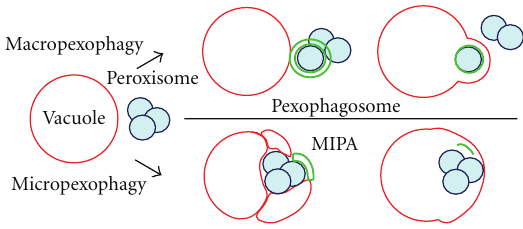
Figure 4: Model of organelle dynamics observed during pexophagy in methylotrophic yeasts. The green portions of the figure (MIPA and pexophagosome) represent autophagic membrane structures newly synthesized by the action of Atg